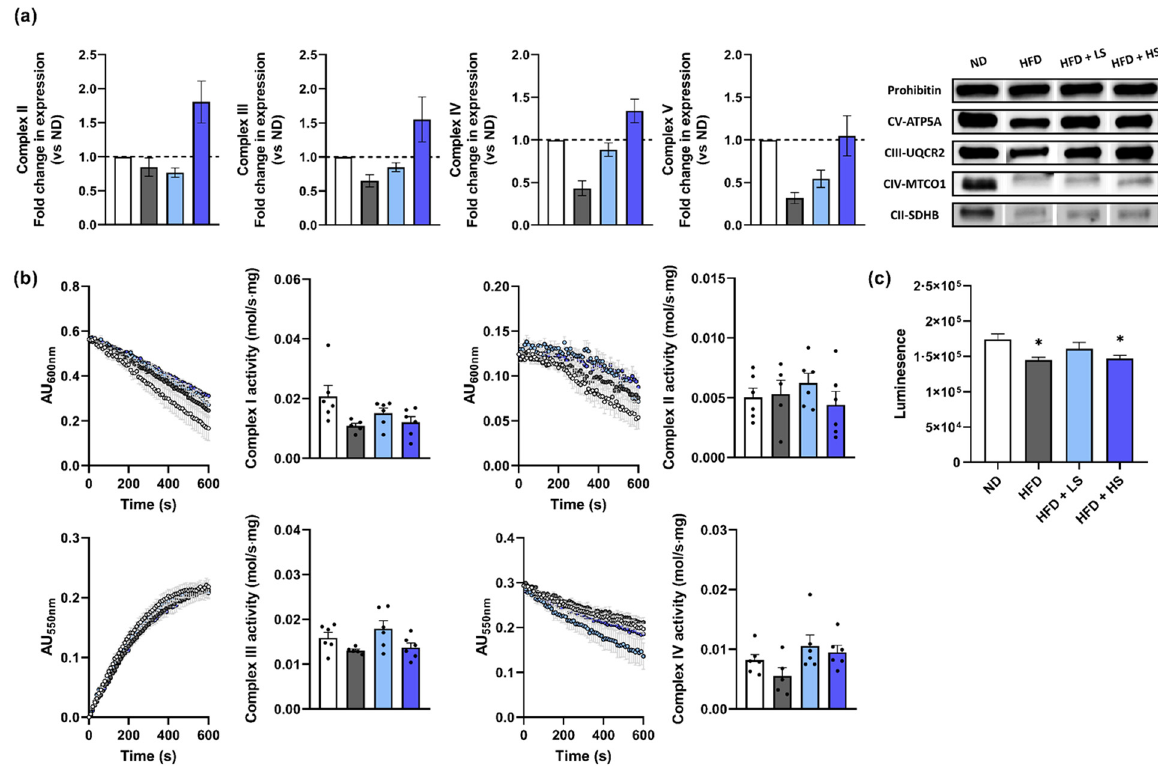
Figure 7. ME increased the expression level of complexes II–V in the liver of HFD-fed mice. ( a ) Normalized expression and immunoblot detection. ( b ) Kinetically monitored activity of complexes I–IV and calculated activity. ( c ) Mitochondrial ATP production. ND = white dots or bars, HFD = gray dots or bars, HFD + LS = light blue dots or bars, and HFD + HS = blue dots or bars. Results are expressed as the mean ± SEM. * p < 0.05 versus ND group. ND, normal diet; HFD, high-fat diet; HFD + LS, HFD plus 0.1% ME; HFD + HS, HFD plus 0.25% ME.